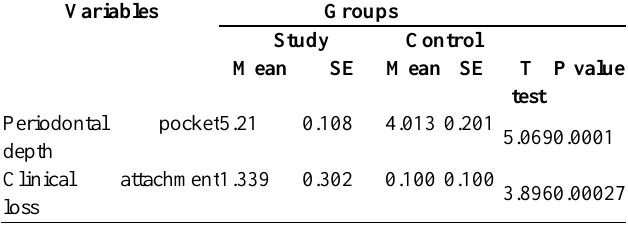
Table 1: Mean values and statistical difference of Periodontal pocket depth and Clinical attachment loss among study and control groups Variables